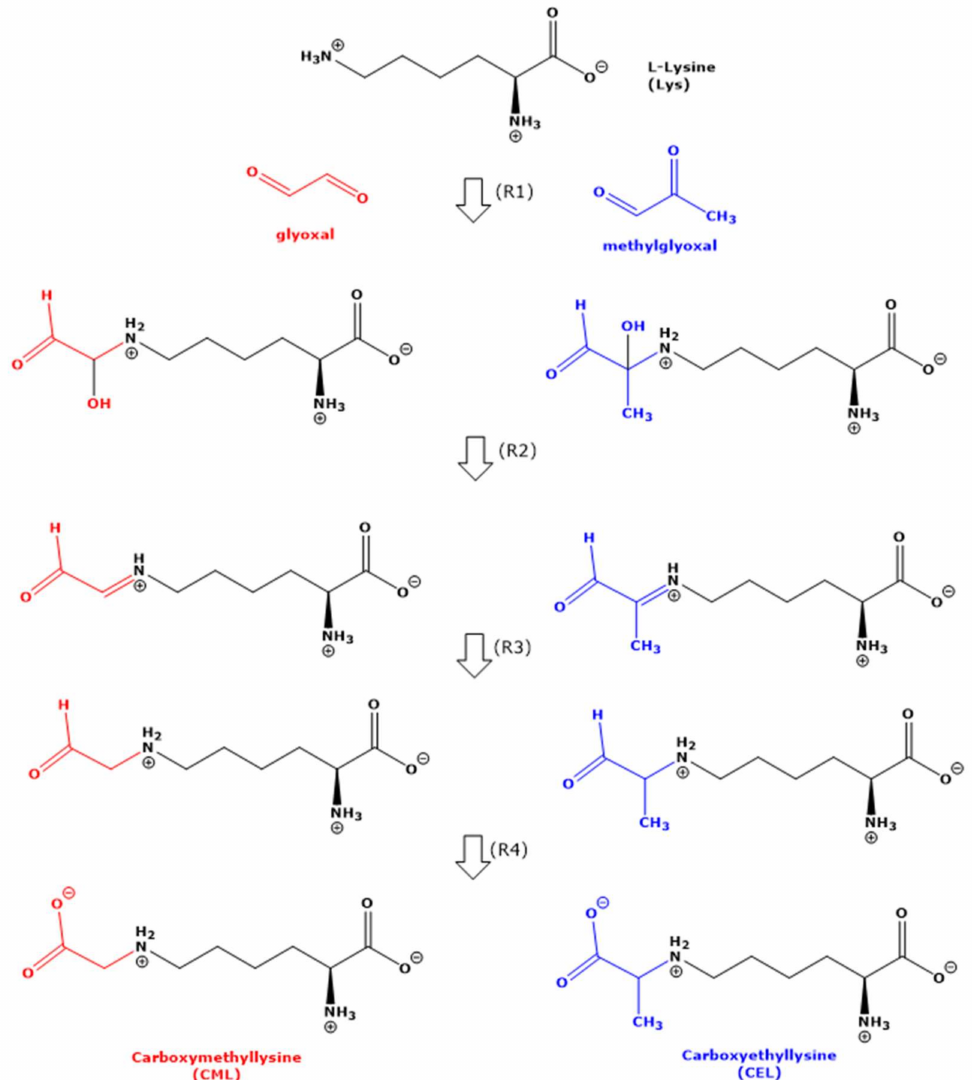
Figure 1. Simplified schematic of the generally assumed reactions (R1 to R4) of the N -terminal N -epsilon ( N ε ) amine group of free non-proteinic L-lysine (L) with glyoxal (GO) and methylglyoxal (MGO) in 100 mM phosphate-buffered (pH 7.4) at 37 ◦ C and 80 ◦ C finally to form carboxymethyllysine (CML) and carboxyethyllysine (CEL), respectively. For simplicity, the reaction of L-lysine with the aldehydic group of MGO is not drawn. For more details, see the